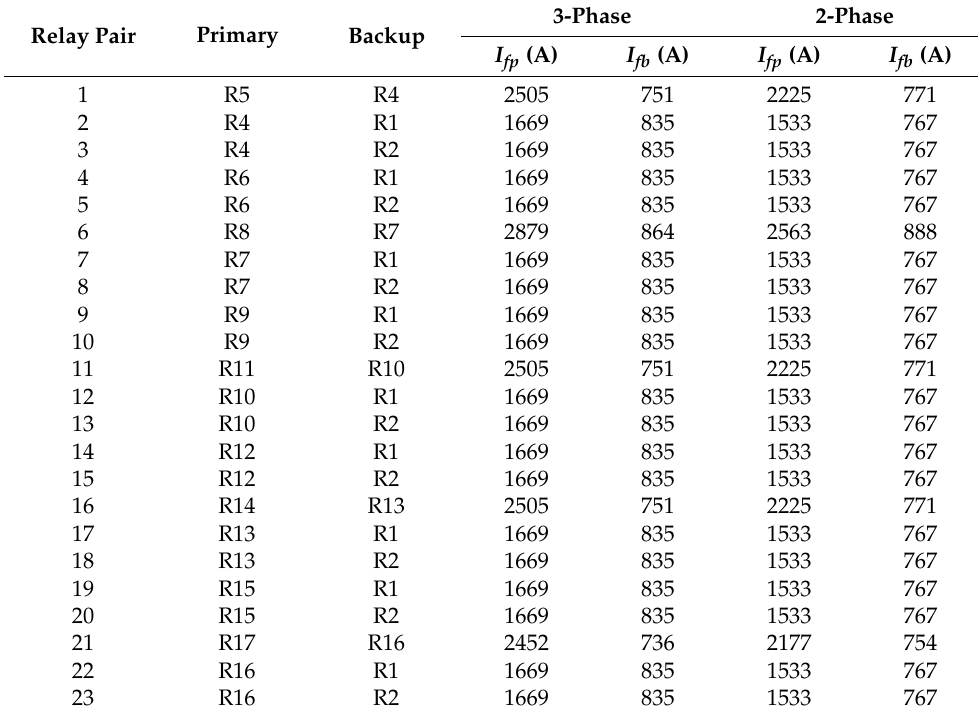
Table A8. Min-Fault Conditions (2 DGs are in service with Bus Coupler 1 and Bus Coupler 2